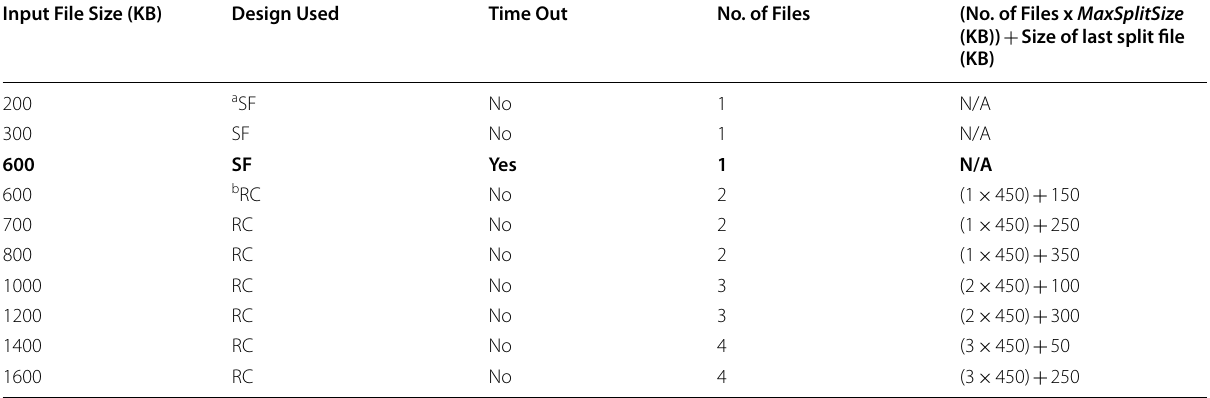
a SF- Single FaaS b RC- Relay